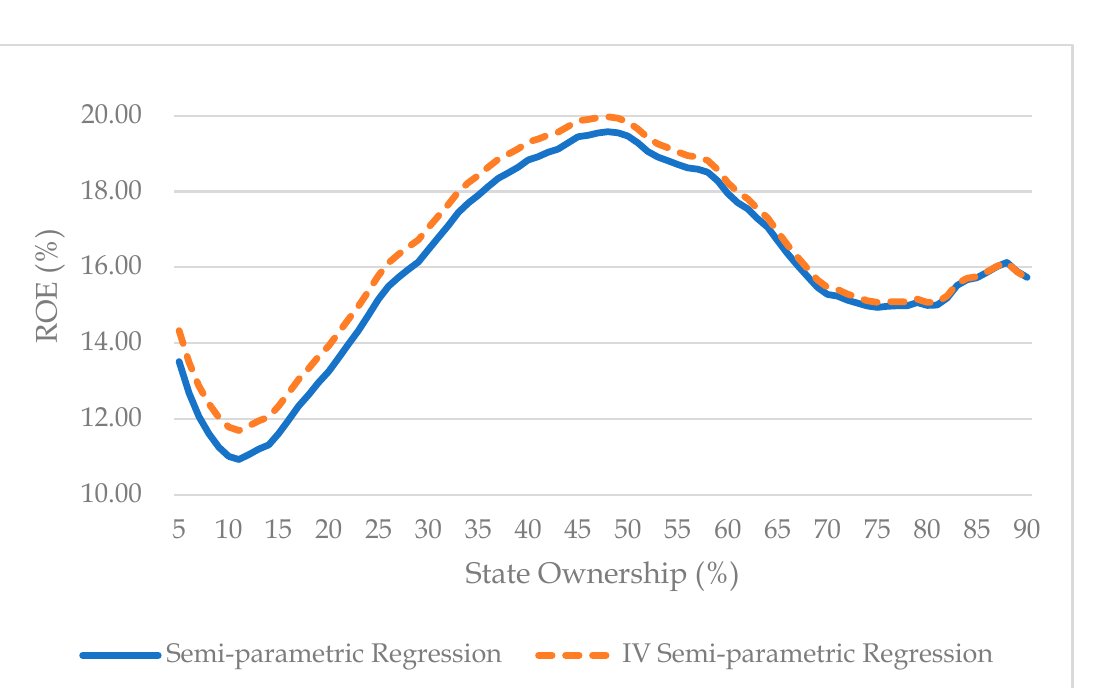
Figure A1. The marginal effect of state ownership (%) on partially privatized firm’s ROA (%) according to both semiparametric regression model and IV semiparametric regression model.